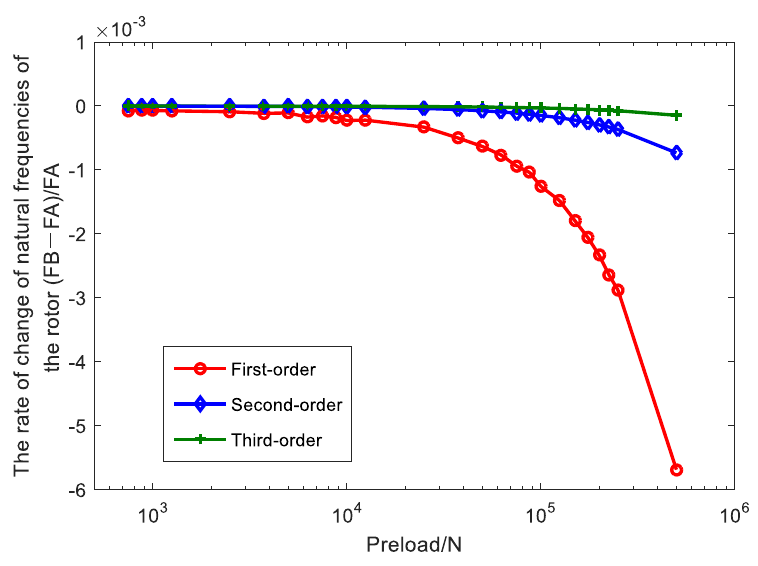
Figure 13. The rate of change of natural frequencies of the RFR considering the influence of preload on the displacement and load transmission of shaft segments.